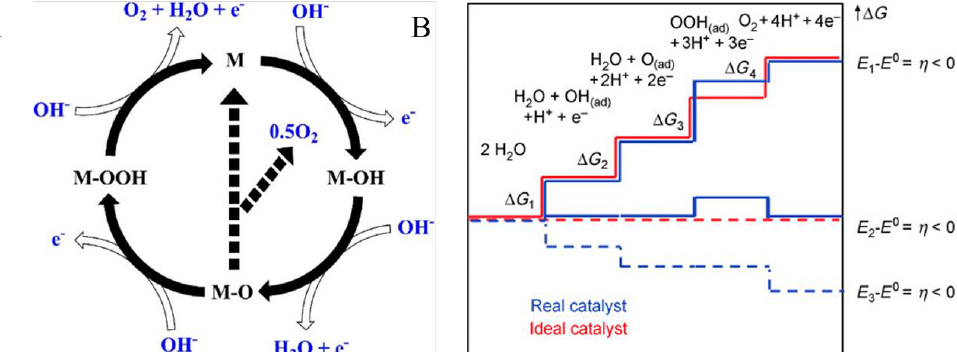
Figure 3. ( A ) Mechanism of OER, where M represents the active site. Reproduced with permission from [44]. American Chemical Society, 2018. ( B ) Plots of Gibbs free energy of reactive species and intermediates of the OER (horizontal lines) vs. the reaction coordinate. At three different electrode potentials, the blue and red lines represent the energetics of a real catalyst and an ideal catalyst, respectively. The energetics at the electrode potential where all thermochemical barriers disappear (“thermoc”) are indicated by dashed lines. Reproduced with permission from [45]. WILEY-VCH Verlag GmbH & Co. KGaA, Weinheim, 2018.